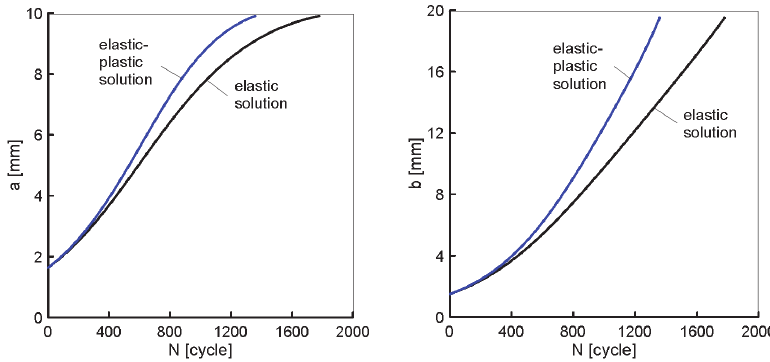
Figure 9: Lifetime prediction based on elastic and elastic-plastic